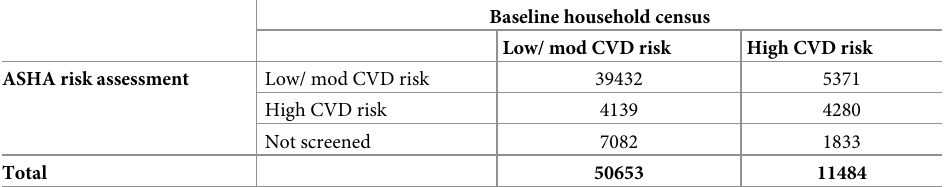
Table 3. Concordance of CVD risk assessment between baseline data collectors and ASHA